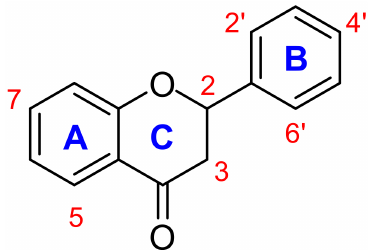
Figure 1. General structure of